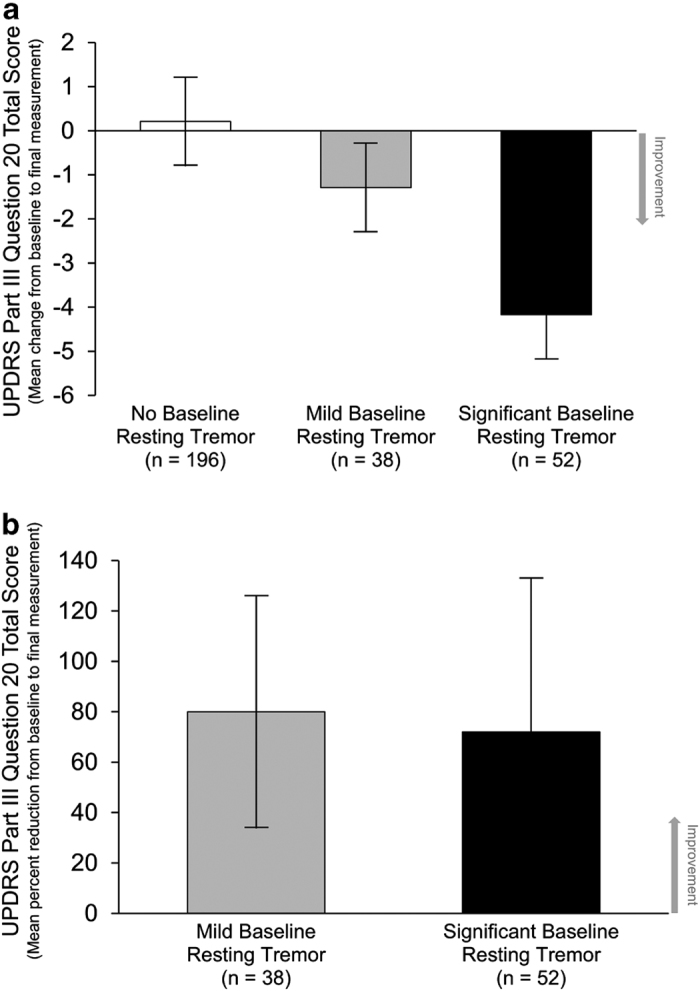
Change in resting tremors (UPDRS Part III Question 20 total score). UPDRS Part III Question 20 total score (a) mean change from baseline to final measurement and (b) mean percent reduction from baseline to final measurement in groups with baseline resting tremor (mild and significant baseline resting tremors). Data are the mean±s.d. UPDRS, Unified Parkinson’s Disease Rating Scale.